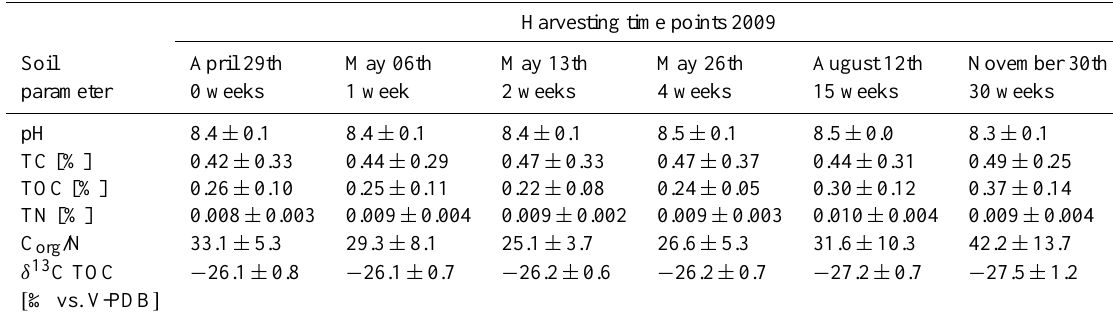
Table 1. Major soil parameters (0–5cm depth) of the soil substrate without litter application throughout the experimental period ( n = 5 ± standard